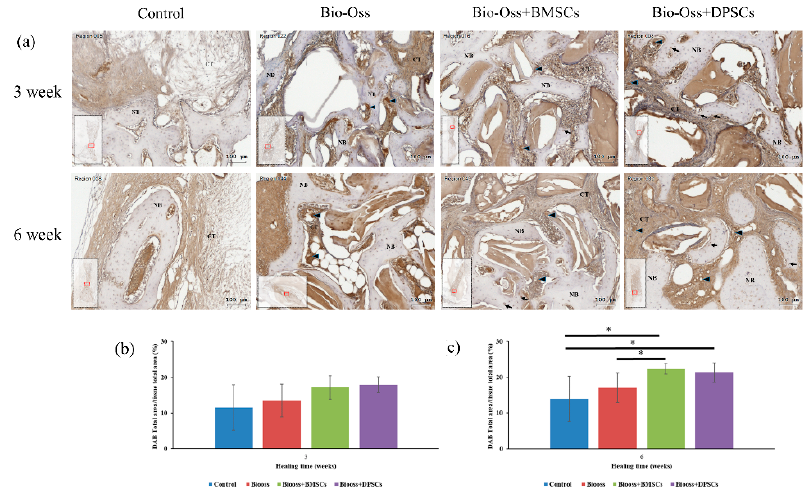
Figure 10. ( a ) Images of osteoprotegerin (OPG) immunostaining in bone defects in control, Bio-Oss, Bio-Oss + BMSC, and Bio-Oss + DPSC groups at 3 and 6 weeks. The black arrowheads indicate osteoblasts at the interface between the bone grafting materials and the newly-formed bone. OPG immunostaining percentages in defect region at ( b ) 3 weeks and ( c ) 6 weeks after surgery as assessed by DAB total area / tissue total area analyses. (NB = new bone; CT = connective tissue. Scale bars = 100 µ m.) (* p < 0.05).